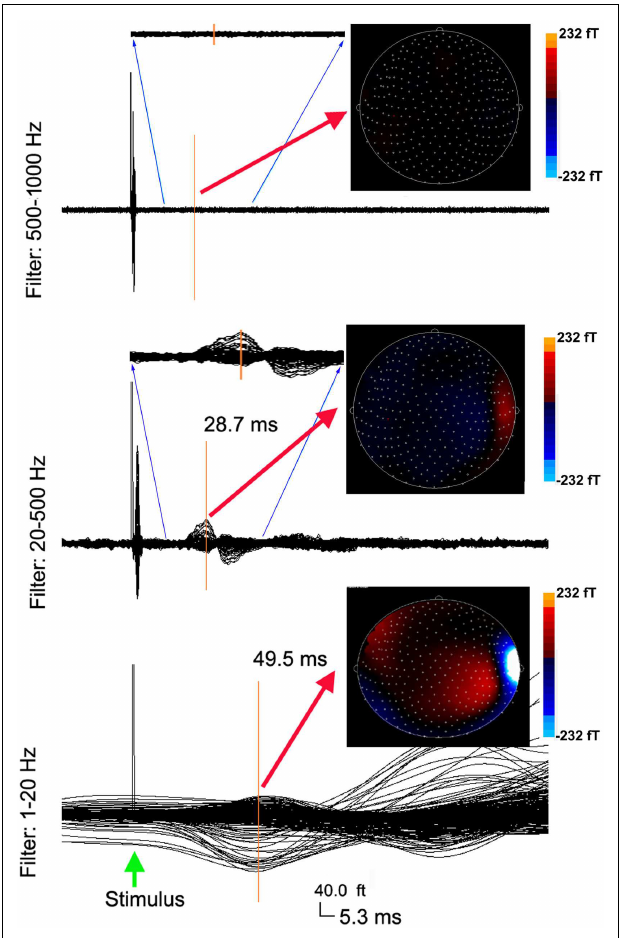
FIGURE 1 |Averaged waveforms and contour maps from a healthy subject showing neuromagnetic activation in 1–1000Hz evoked by left finger stimulation .The three sets of waveforms are filtered by three band-pass filters of 1–20, 20–500, and 500–1000Hz, respectively.The amplitude of neuromagnetic activation decreases with the increase of frequency range.The latency of neuromagnetic activation shortens with the increase of frequency range.The three sets of waveforms have the same time (“5.3ms”) and amplitude (“40.0ft”) scales (the bottom).Waveforms in the 20–500Hz range and the 500–1000Hz range reflect a full time scale, as well as a “zoomed in” time scale from 10 to 30ms to show the detailed deflections.The color contour maps show the distributions of neuromagnetic activation. All the contour maps have the same color scales.